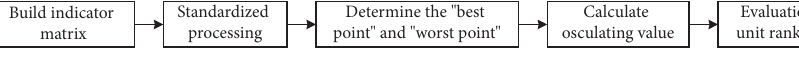
Figure 1: Osculating value method flowchart.